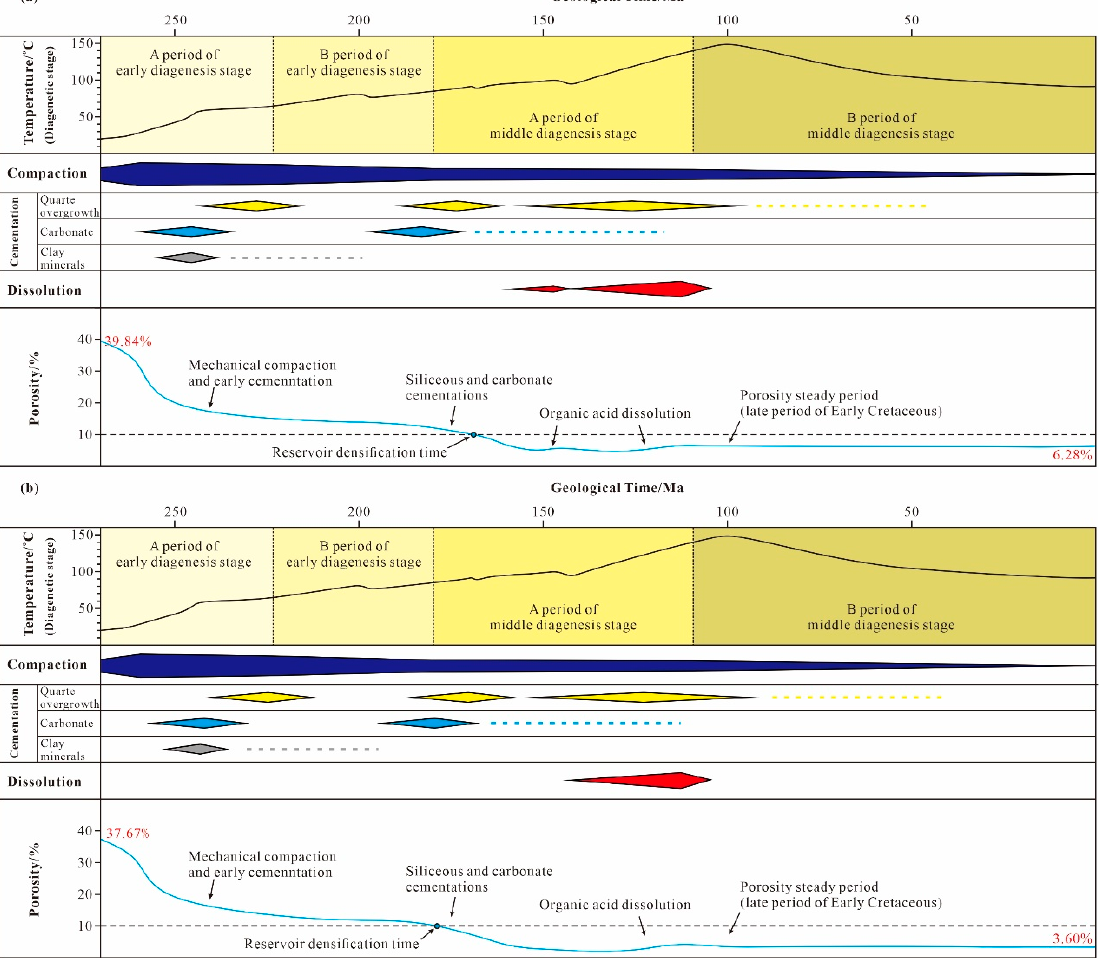
Figure 8. Boxplot of porosity of Lower Shihezi Formation tight sandstones in the Duguijiahan block, Ordos Basin.